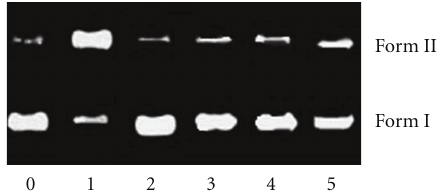
Figure 7: Photoactivated cleavage of pBR 322DNA in the presence of 20 μ M of complex 1 and di ff erent inhibitors after irradiation at λ > 400nm for 60 minutes. Lane 0, DNA control; lane 1, no inhibitor; lanes 2–6: (2) histidine (5mM), (3) DMSO (0.2M), (4) ethanol (0.2M), (5) sodium formate